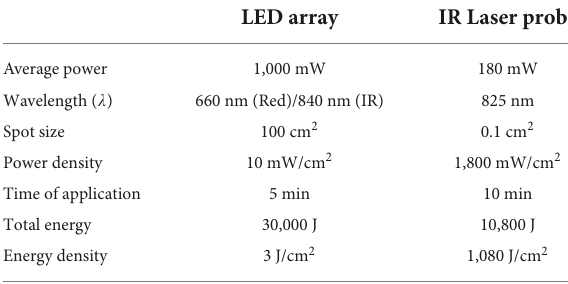
TABLE 2 Specifications for LED array and IR laser